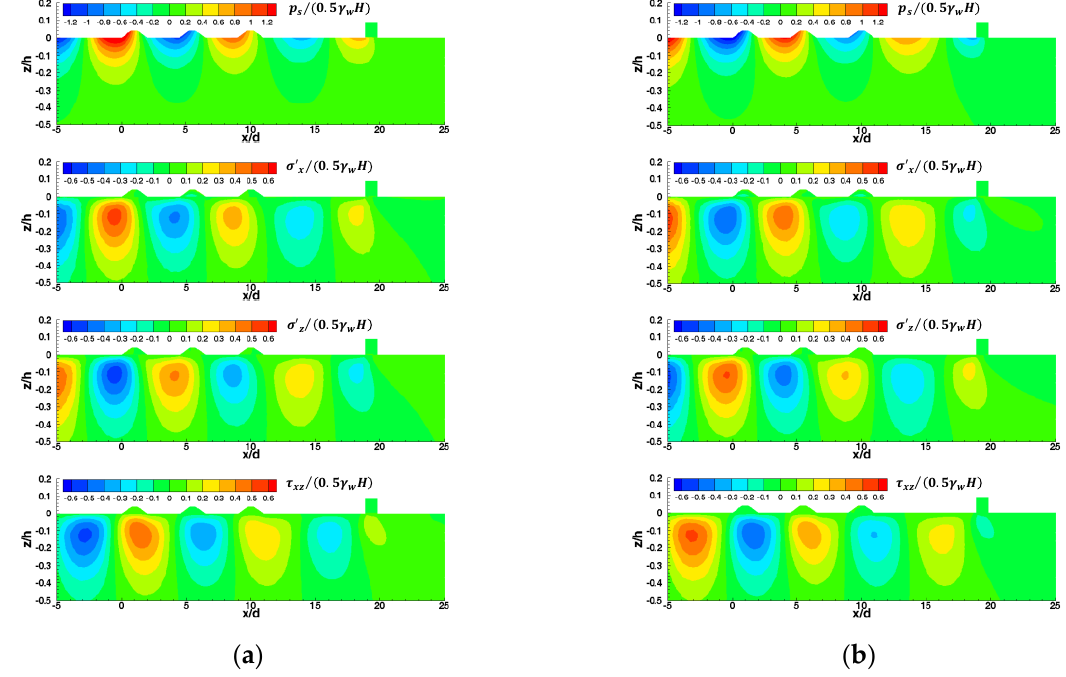
Figure 18. Distribution of the wave-induced dynamics of the seabed around the breakwaters ( m = 3 ) with a period of T = 3.16 s under Mode 1 (at S / L = 0.75) ( a ) t / T = 0.25; ( b ) t / T = 0.75.